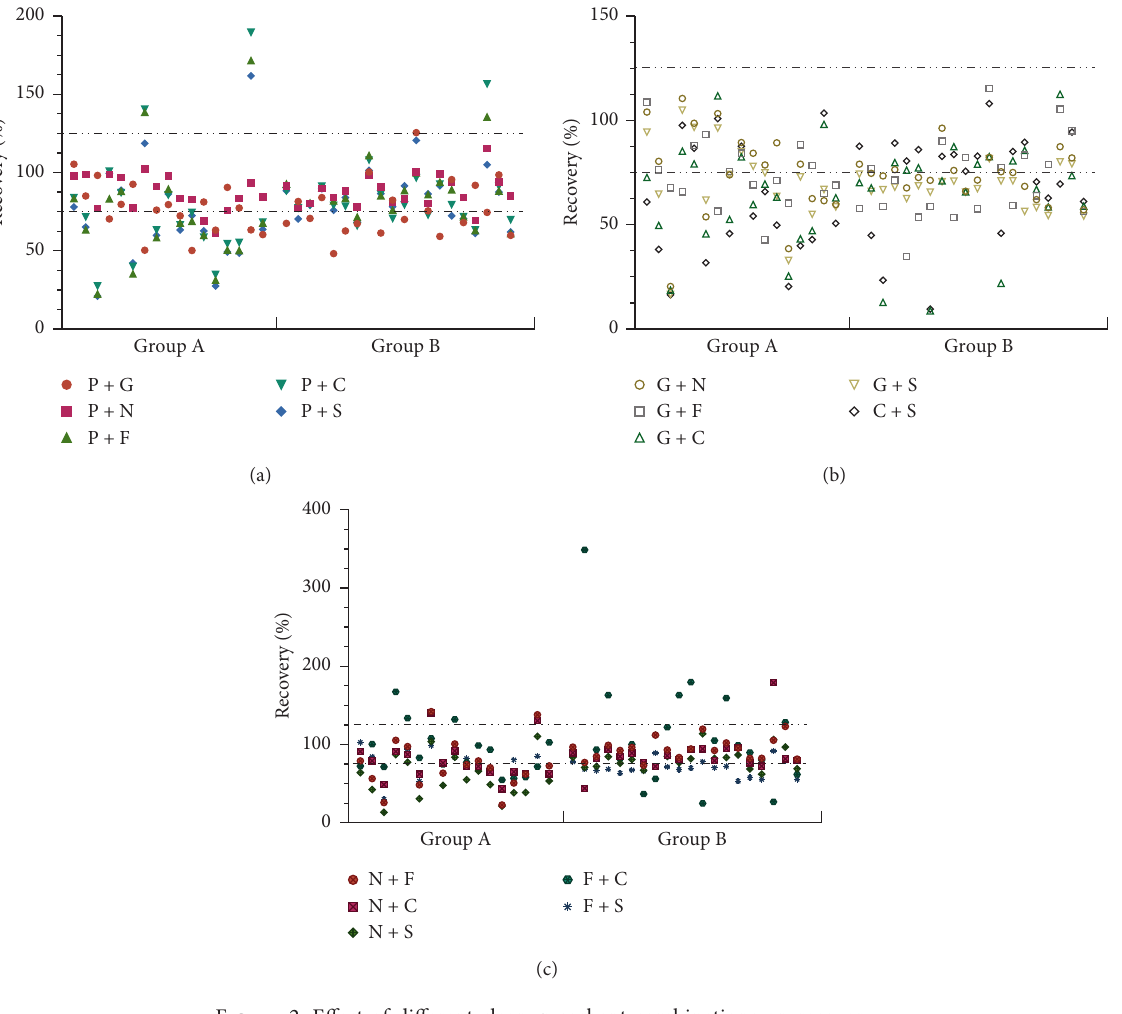
Figure 2: Effect of different cleanup sorbent combinations on recovery.